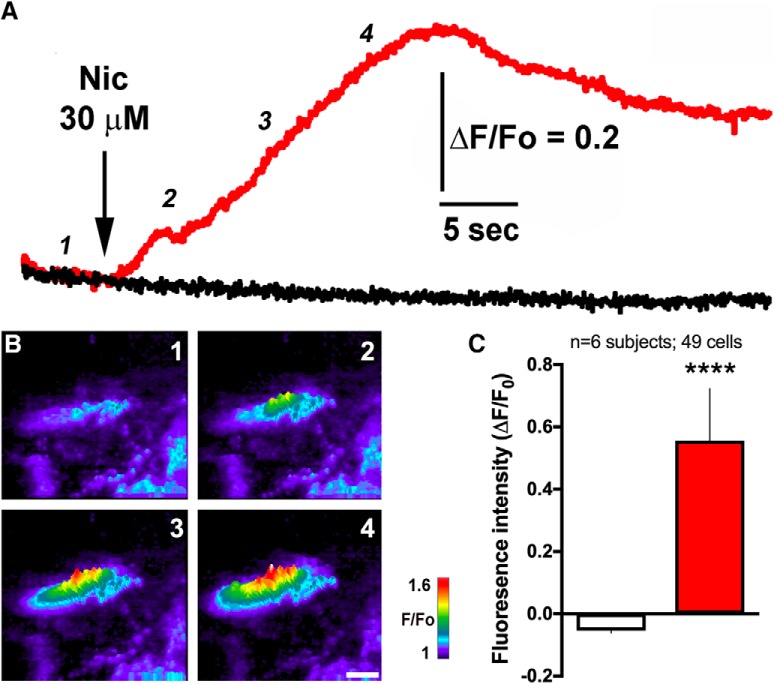
Nicotine activates calcium signaling in choroid plexus epithelial cells in vitro. A, Time course of Ca2+-dependent fluorescence signal recorded from responding (red) and nonresponding (black) cells following application of 30 μM nicotine. Traces represent average intensity from nine responsive (red) and 40 nonresponsive (black) primary choroid plexus epithelial cells in vitro. Primary choroid plexus obtained from n = 6 rats (five cell culture plates analyzed, resulting in 49 cells quantified). B, Representative images of a responsive cell (center) and nonresponsive cells (bottom right) captured at the time points 1–4 as indicated in A. Increasing cytosolic free Ca2+ is represented by warmer colors (as depicted with the color bar) and increasing height of each pixel. Scale bar = 20 μm. C, Average fluorescence signals measured at the peak of each recording obtained during 11 separated trials; ****p < 0.0001. Data represent mean ± SEM. Central tendency (mean) and variation (SEM) values for each are as follows: nonresponsive, –0.054 ± 0.008 and responsive, 0.556 ± 0.167.